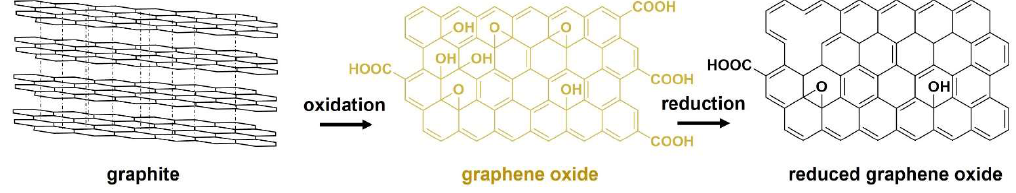
Figure 1. The chemical production of graphene oxide from